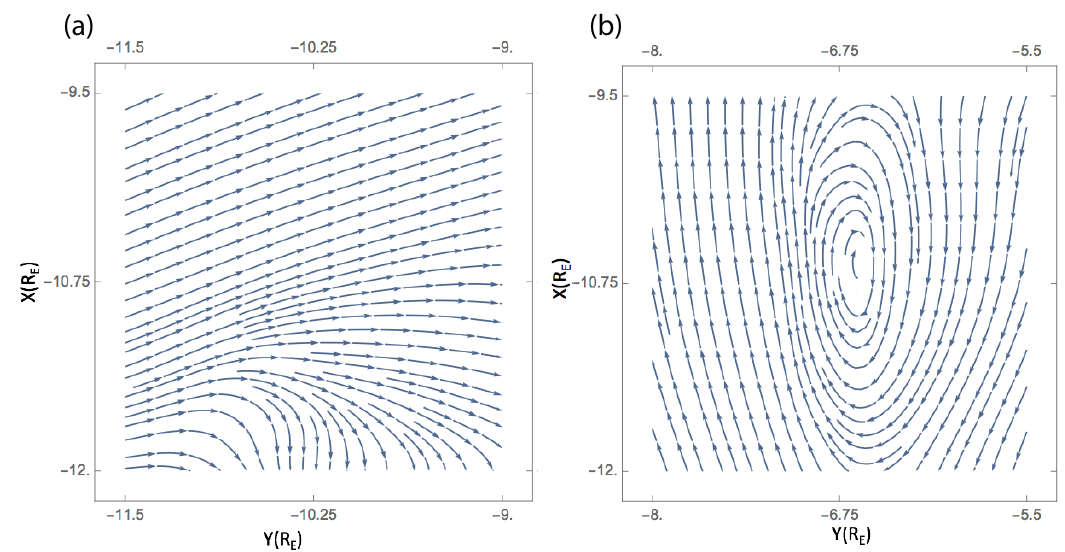
Figure 1. Streamlines are mapped to show an example of the method used to identify vortices in the data. If the norm of R is greater than the norm of S , we consider this point to lie at the center of a possible vortex. In (a) we have the case where | S | > | R | and in (b) | R | > | S | where the location of a vortex is then